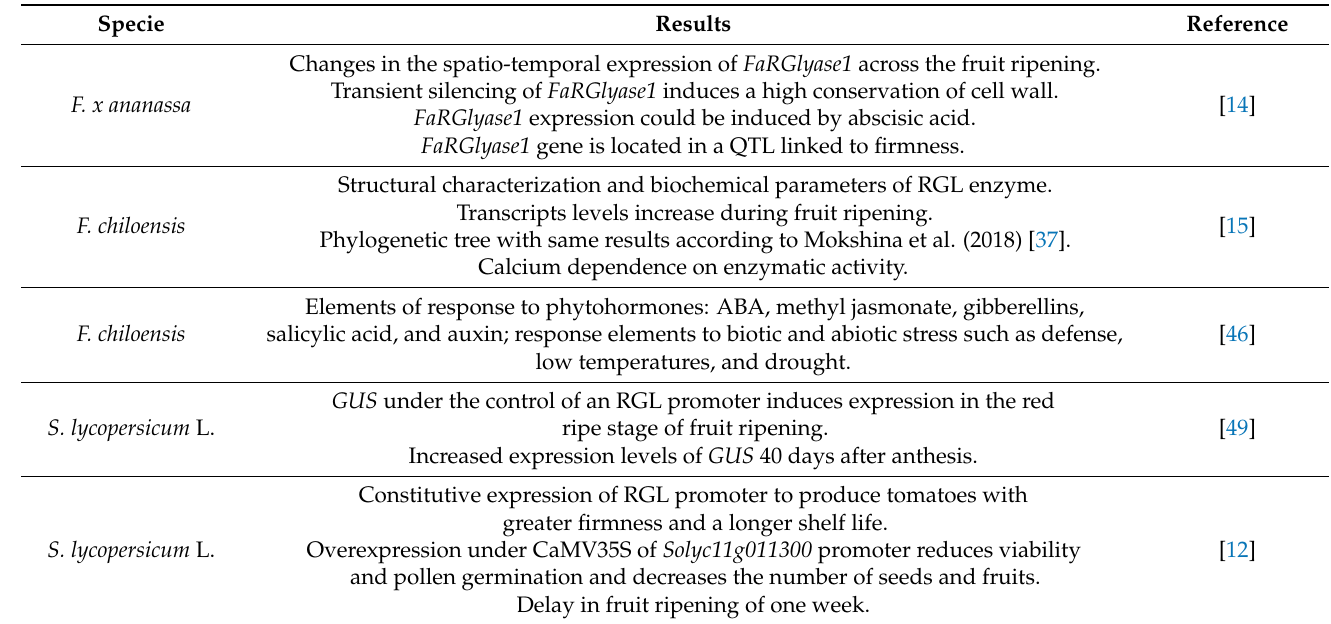
Table 2. Summary of results obtained in research on RGL, until the year